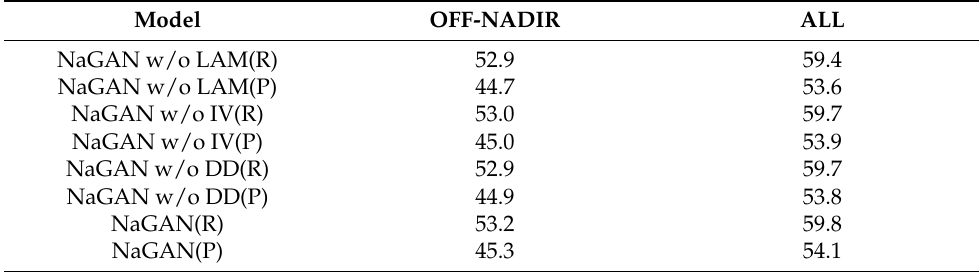
Table 2. Performance comparison about label alignment and its variant on SpaceNet. (R): AR@0.5, (P): AP@0.5. (In